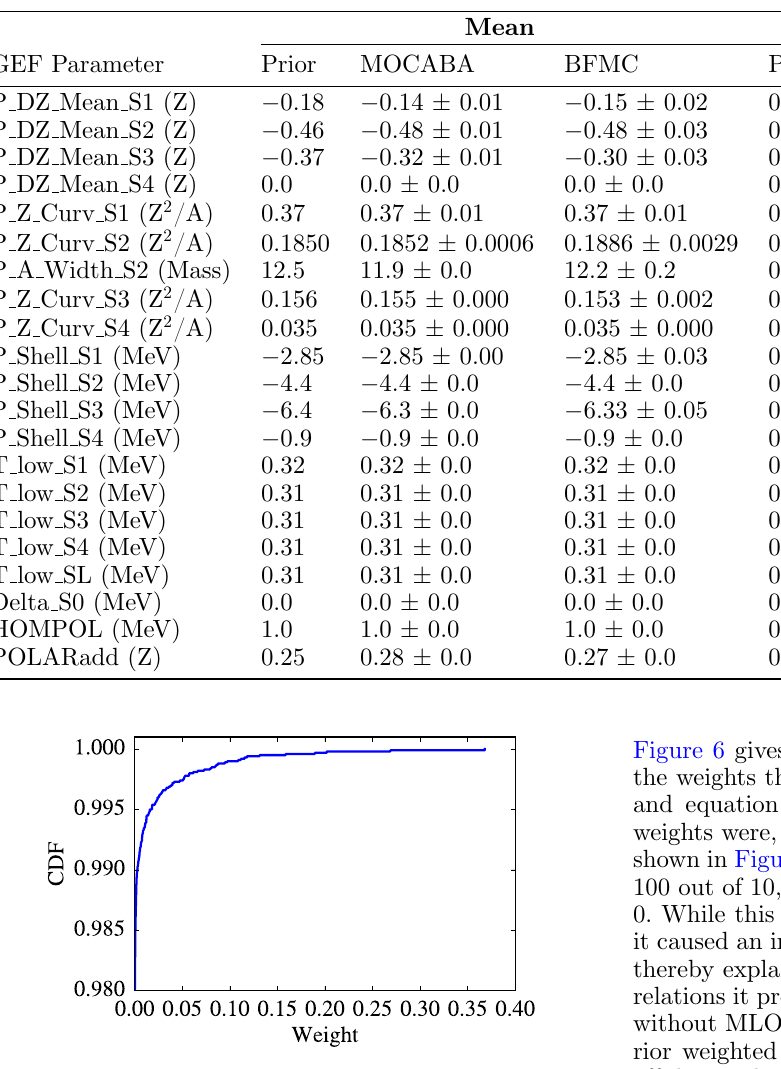
Fig. 6. CDF of BFMC’s weight